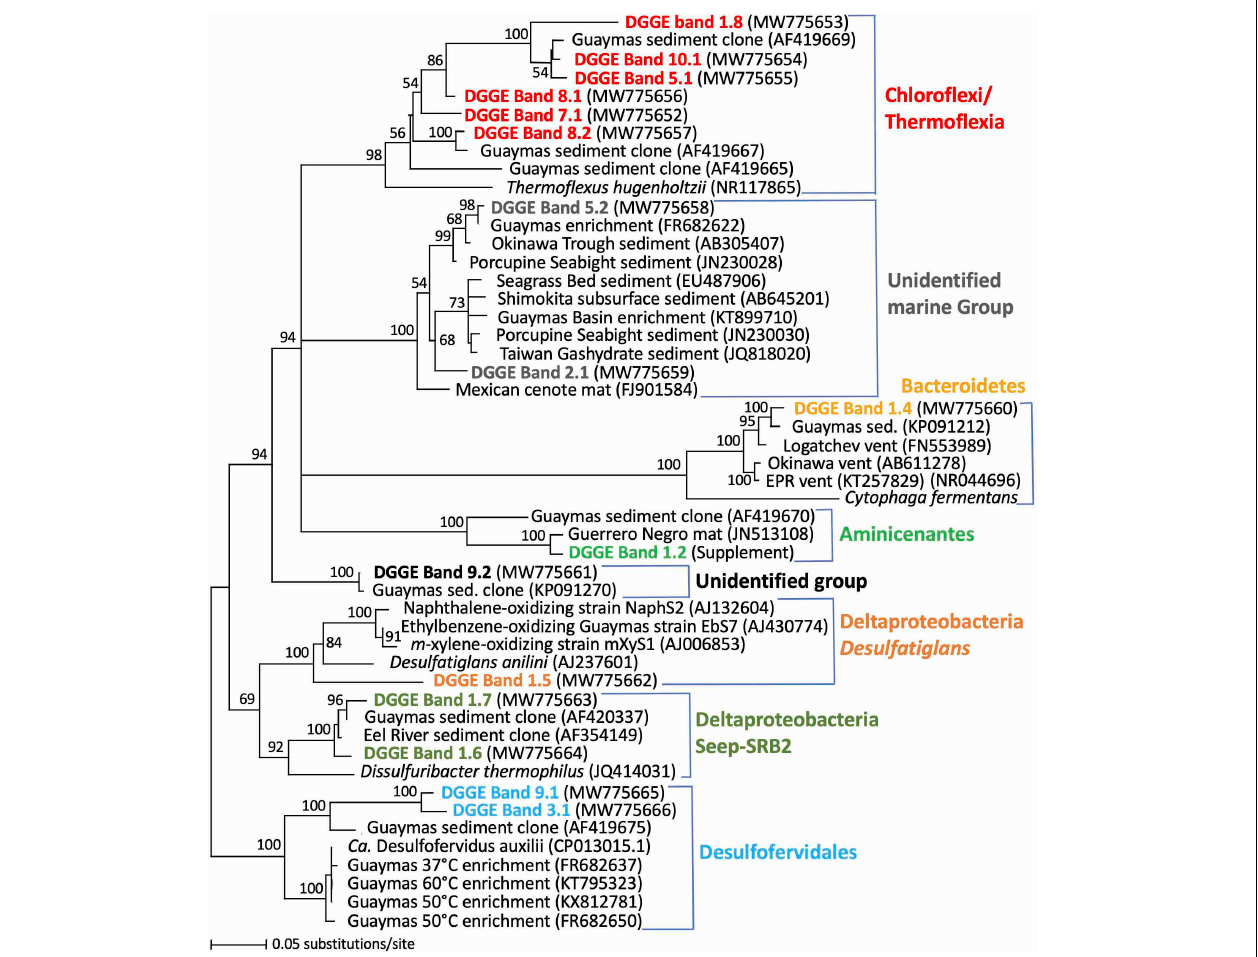
FIGURE 3 | Distance phylogeny of bacterial 16S rRNA gene DGGE fragments based on complete amplicon length minus primer sequences, color-coded to match the DGGE bands in Figure 2 . The sequence of DGGE band 1.2 is provided in Supplementary Table 2 . Bootstrap support for nodes (in%) was derived from 1000 iterations. The scale bar in this and subsequent phylogenies shows sequence distance (Minimum Evolution) as specified in Materials and